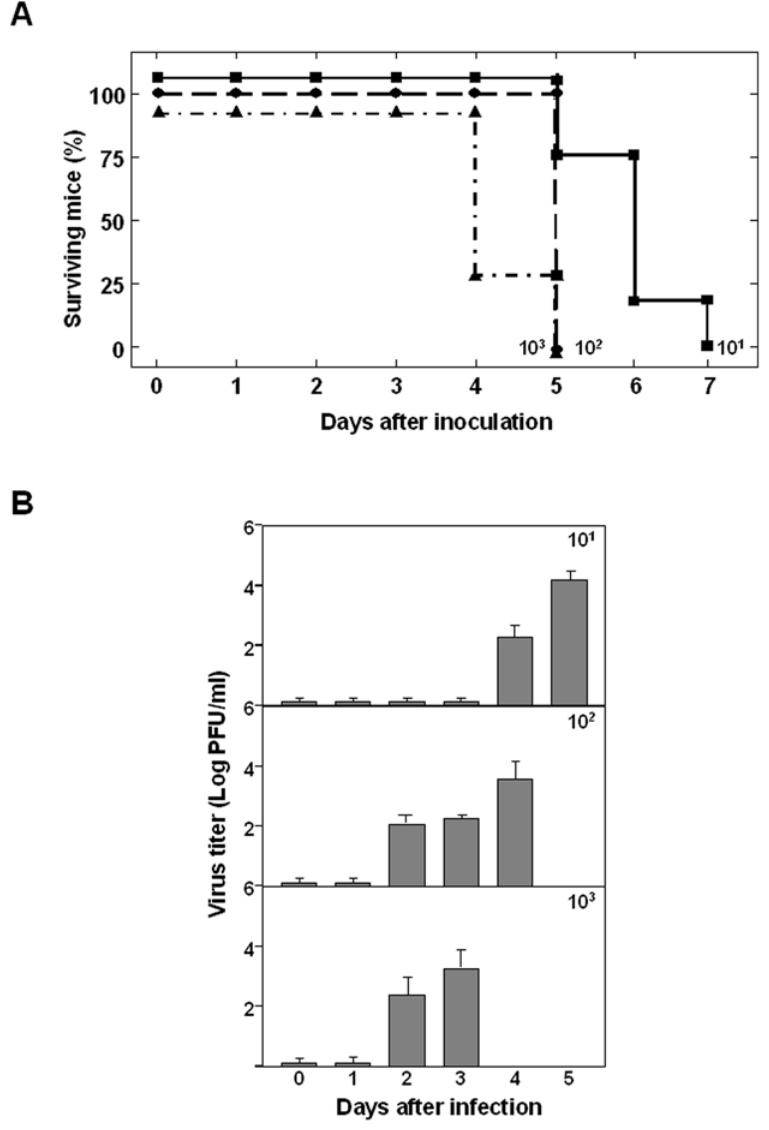
Figure 3. Survival rates of IFNAR ( 2 / 2 ) mice and virus titers in blood after inoculation with BTV-8. (A) Mice (8 weeks old, 6 mice per group) were intravenously inoculated with 10-fold dilutions of BTV-8. The number of PFUs inoculated is indicated on each survival group. The mice were observed every 24 h for 7 days. (B) Titers of BTV-8 recovered in blood after intravenously infection with 10-fold dilutions of BTV-4. The number of PFUs inoculated is indicated on each survival group. Virus was extracted from blood and determined as described in Materials and Methods. Each point represents the mean values of the viral titer of six animals, and standard deviations are shown as error bars.